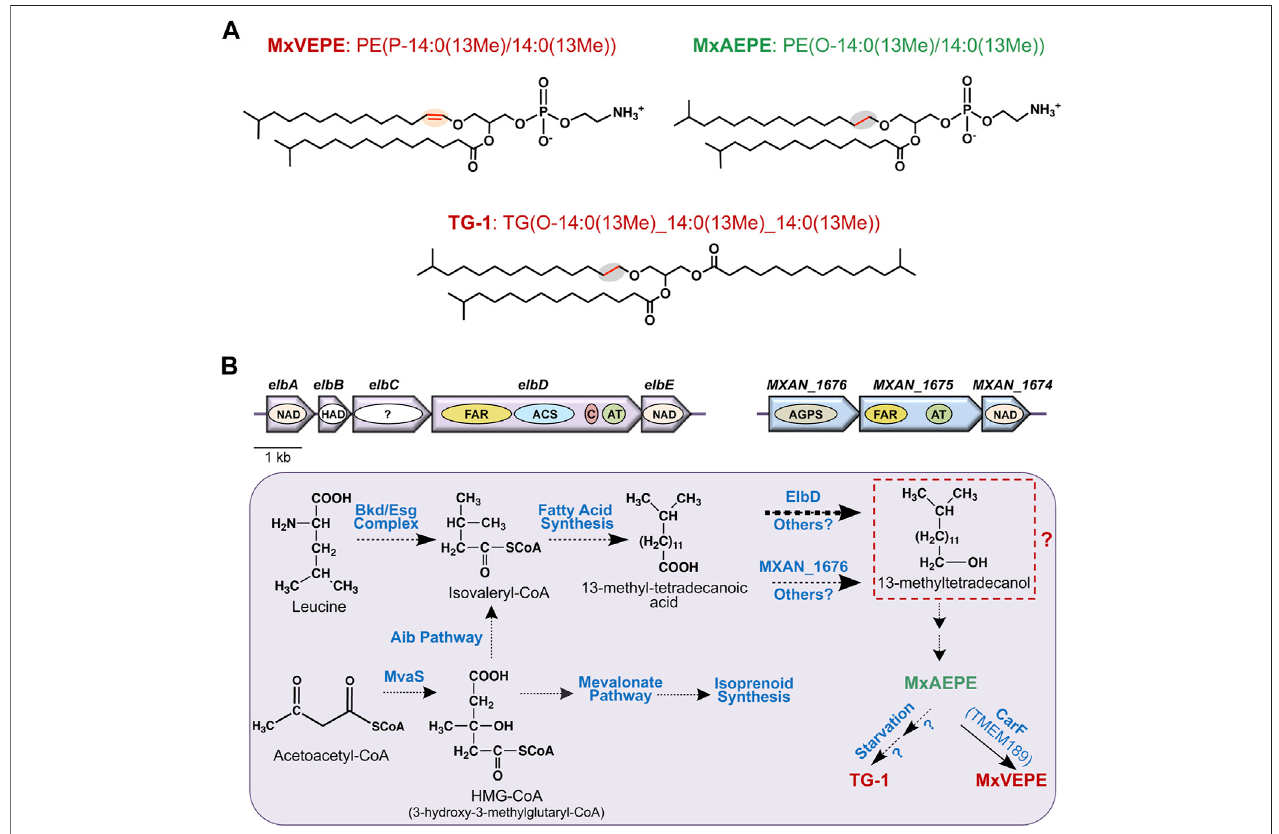
FIGURE3| M.xanthus alkyletherlipids,plasmalogensandtheirbiosynthesis. (A) M.xanthus plasmalogenMxVEPE:1-(13-methyl-1Z-tetradecenyl)-2-(13-methyl- tetradecanonyl)-sn-glycero-3-phosphoethanolamine; its alkyl ether (plasmanyl) precursor MxAEPE: 1-(13-methyl-tetradecanyl)-2-(13-methyl-tetradecanoyl)-sn- glycero-3-phosphoethanolamine; and the alkyldiacylglycerol ether lipid TG-1: rac1,2-di-(13-methyltetradecanoyl)-3-(13-methyltetradecyl)-glycerol. LIPID MAPS Structure Database (https://www.lipidmaps.org/databases/lmsd) systematic and common names are used. (B) Plasmalogen biosynthesis pathway in M. xanthus highlighting known and proposed steps. Top: The elbA-elbE and the MXAN_1676-MXAN_1674 operons. Arrows indicate genes and the ovals inside depict proteins or putative domains. AGPS, FAR, and ACS are as in Figure 2 , AT is acyltransferase (AGPAT/GNPAT-like); C is acyl-carrier protein or ACP; NAD is an NAD-dependent epimerase/dehydratase family protein; “ ? ” is a protein domain of unknown function. Bottom: Proposed and known steps in M. xanthus plasmalogen biosynthesis. Broken arrows indicate multiple steps involved, and the thick arrow for ElbD indicates this pathway is predominant. Steps from the iso-branched fatty acid to the alkyl ether lipid MxAEPE are unknown and may involve hypothetical conversion to a fatty alcohol (red dashed box) as in the mammalian aerobic plasmalogen biosynthesis pathway.